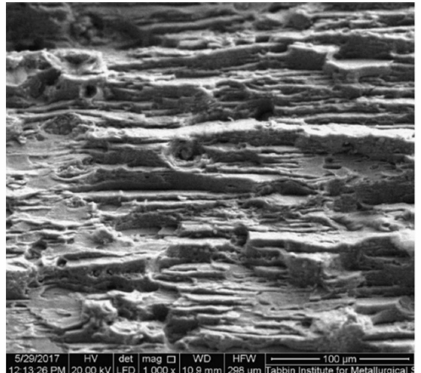
Figure 15. SEM photographs of the tensile fracture surface of the base